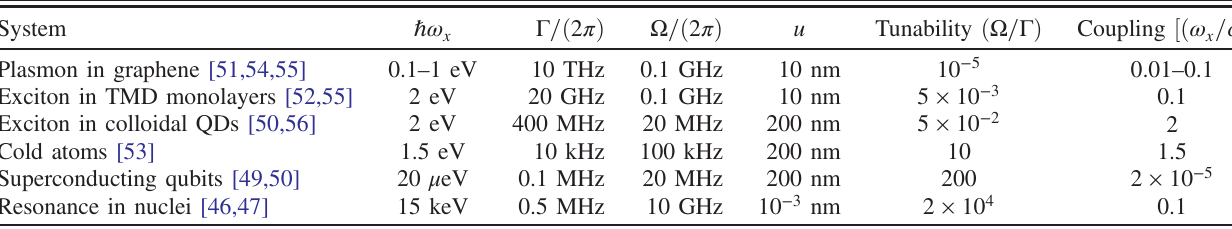
TABLE I. Parameters of various resonant optomechanical systems.